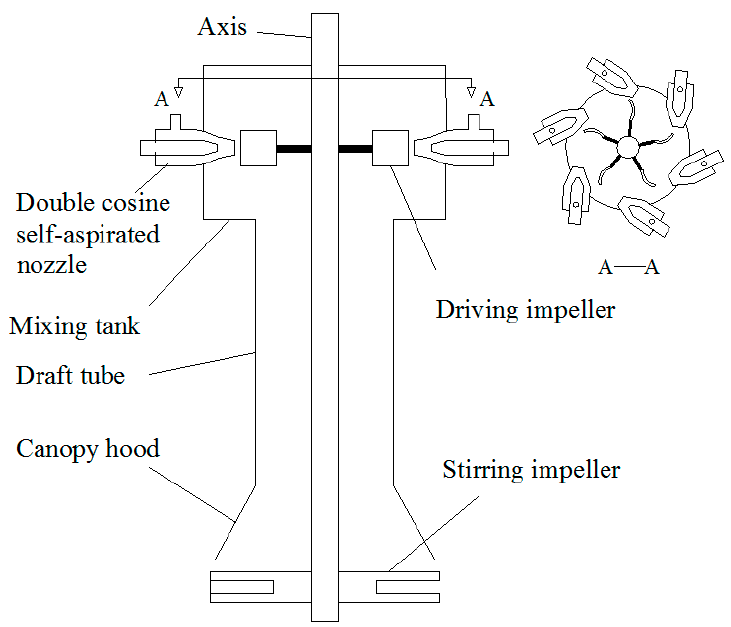
Figure 1. Schematic of the jet-stirring coupling flotation device.